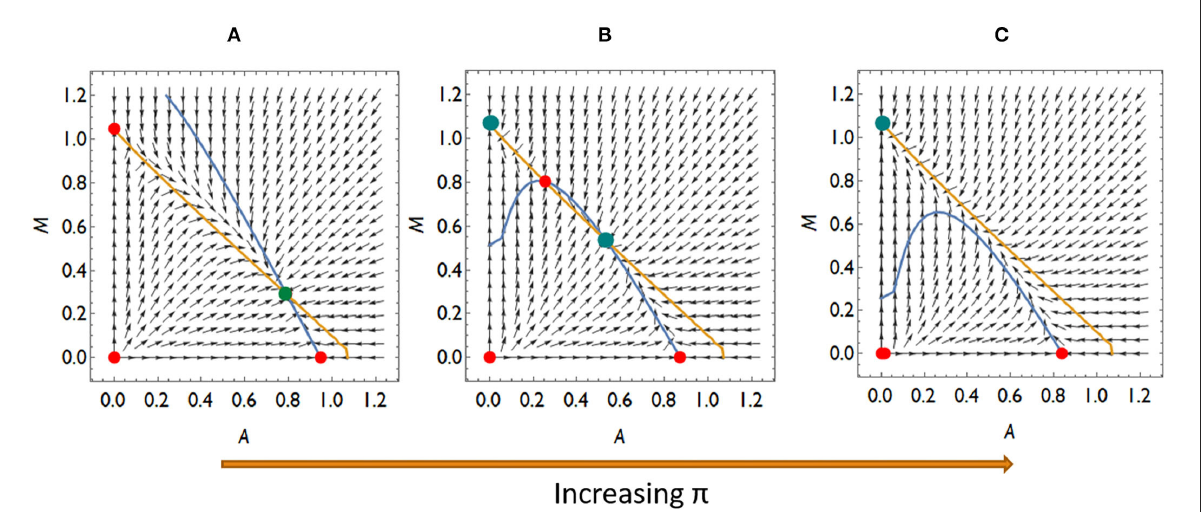
FIGURE5 The qualitatively different dynamics of the Mycoplasma–Aliivibrio system when rare Mycoplasma always invades Aliivibrio . The nullclines of (1–2) are depicted (yellow dM/dt = 0, blue dA/dt = 0). Red dots denote the unstable fixed points, green ones denote the stable fixed points of the system. At low-relative immune efficiency ( π ), rare species invade and Mycoplasma are in coexistence with Aliivibrio (A) . At intermediate π the system is bistable (B) , while at high π Mycoplasma dominates the dynamics (C) . Parameters: (A) π = 0.4, (B) π = 0.9, (C) π = 1.1, (D) other parameters are the same for all subfigures: r A = r M = 1, a AM = 0.5 a MA = 0.9, ε = 0.1, σ = 0.5, δ = 0.1, β = 0.5, µ = 7